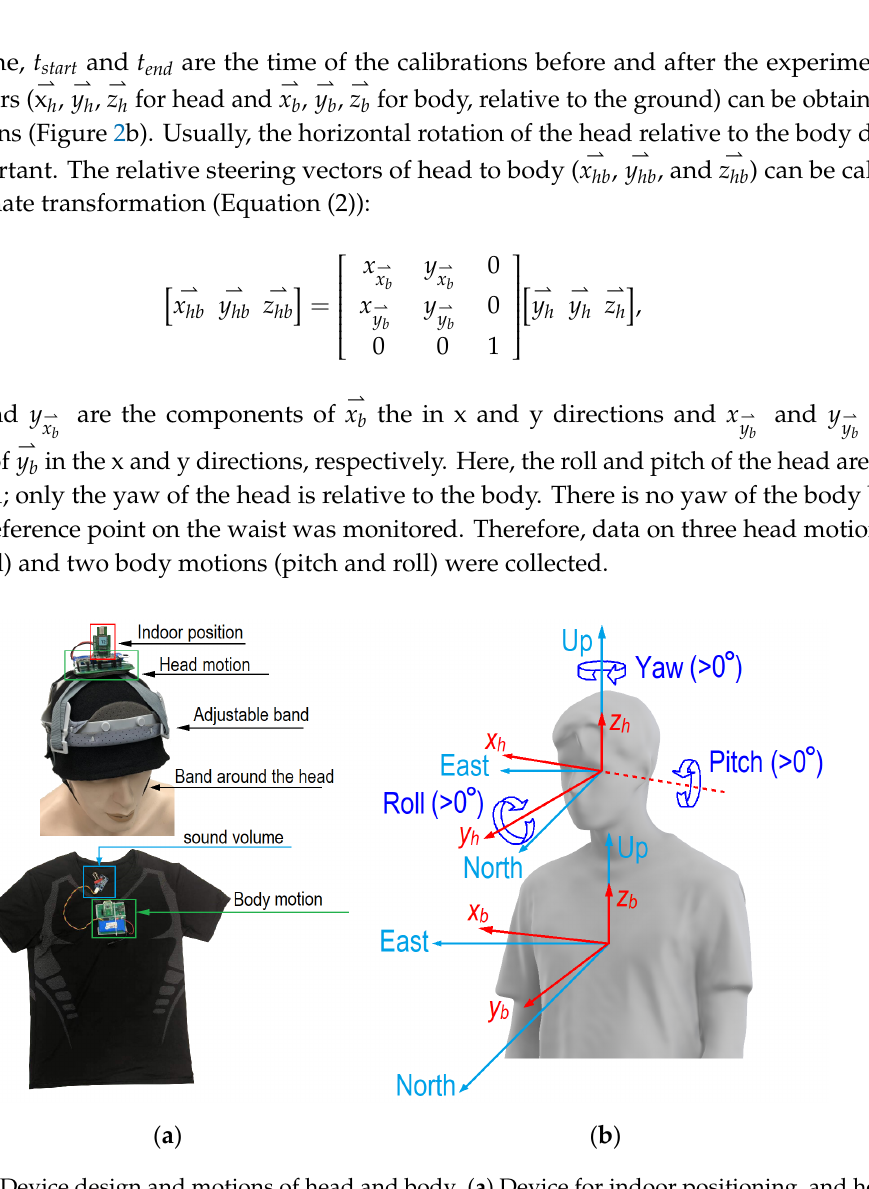
Figure 2. Device design and motions of head and body. ( a ) Device for indoor positioning, and head and body motion detection; ( b ) current and base vectors for head and body.